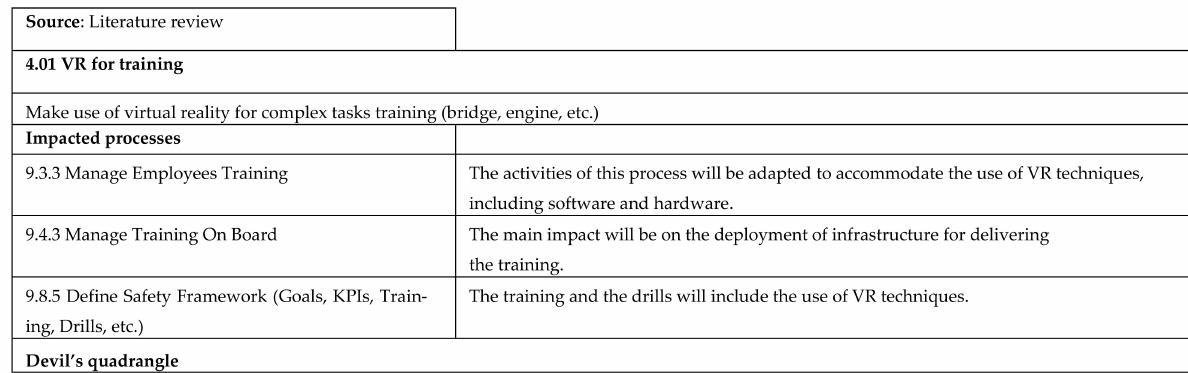
Figure A33. Cont